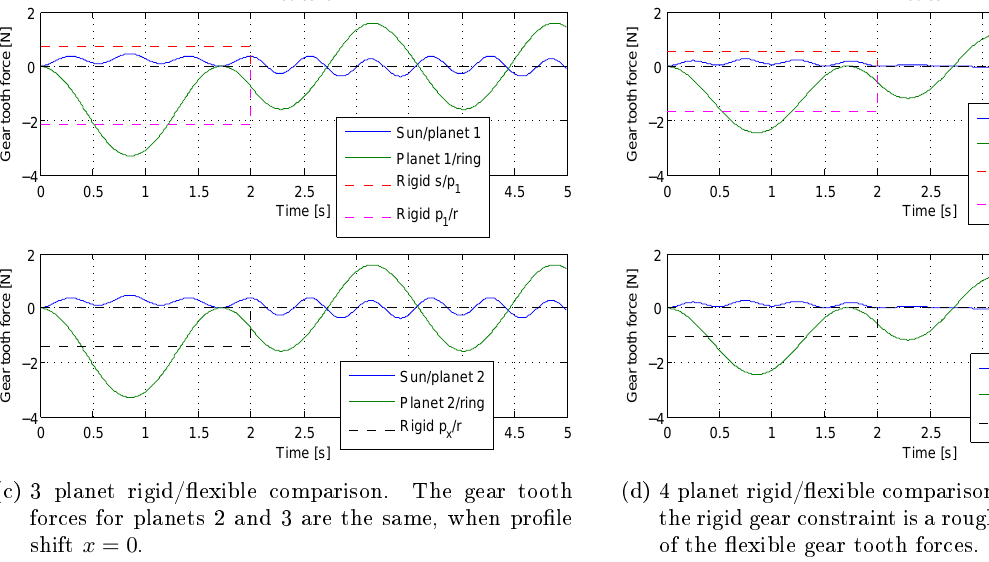
(b) 2 planet rigid/(cid:29)exible comparison. As shown in Fig- ure 2, only planet 1 has both gear constraints at sun/planet and planet/ring.